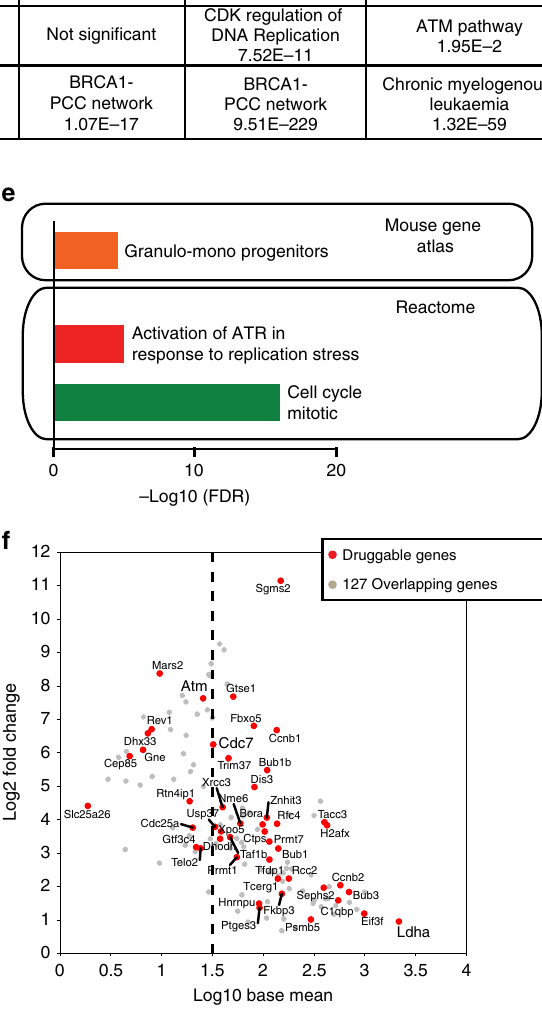
Methods Materials and methods are summarised below, with more detailed experimental protocols provided in Supplemental